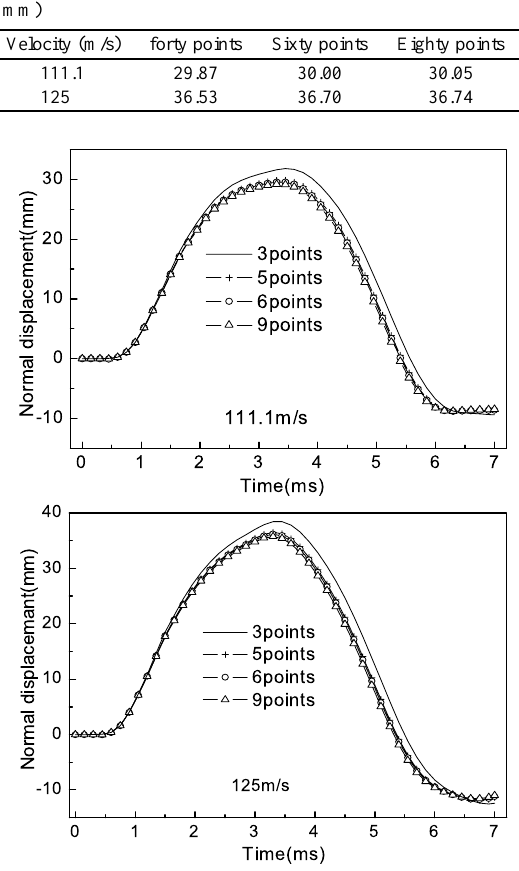
Fig. 11. Time history of normal displacement at the center on inner surface for different mesh seeds along thickness of windshield. displacements at the center on inner surface and that on outer surface are given in Tables 3 and 4, respectively. It